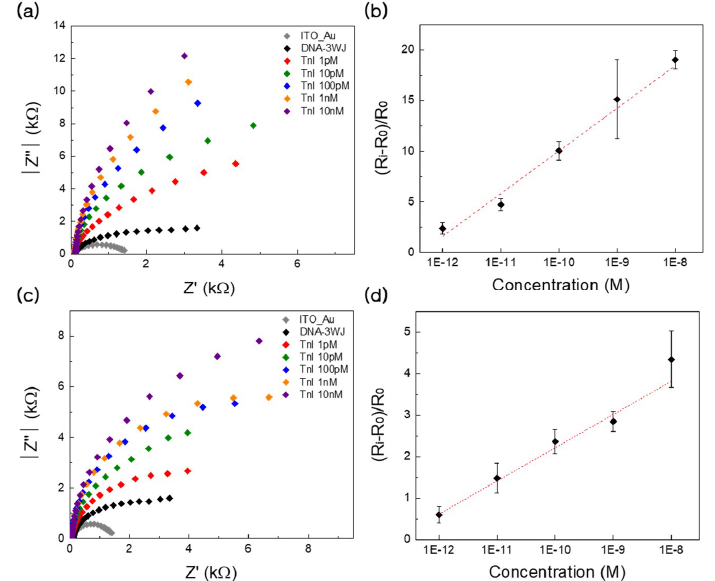
Figure 5. ( a ) Electrochemical impedance spectra of DNA 3WJ / AuNC on ITO substrate with various concentrations of cTnI in dimethylamine bu ff er (from 1 pM to 10 nM). ( b ) The relationship